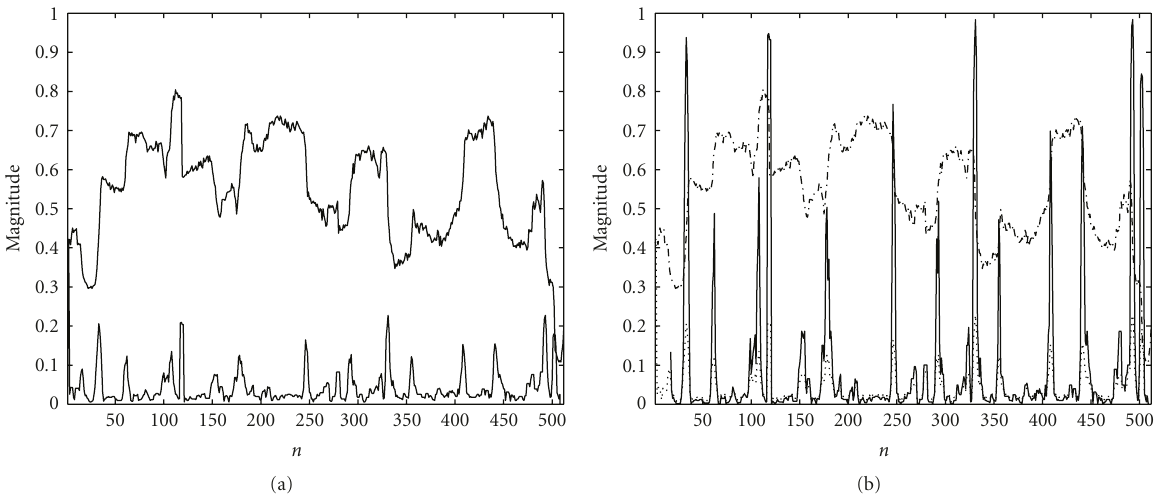
Figure 2: E ff ects of S -function on edge enhancement (a) Original signal and edge detected, (b) S -function enhanced version (solid edges) of (b).